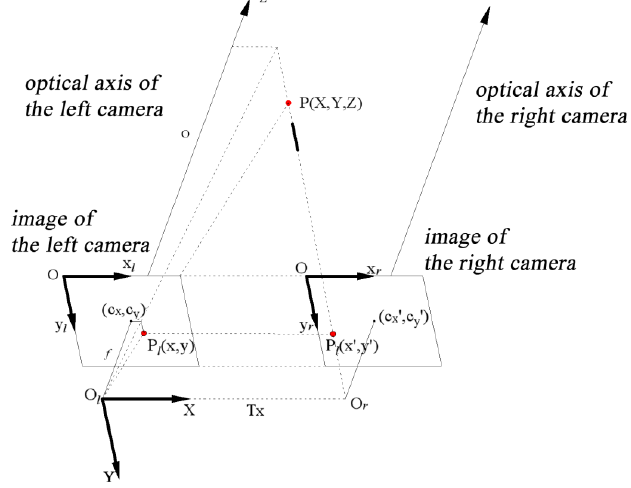
Figure 1. Binocular camera optical axis parallel model. In the optical axis parallel model, the projection point and image coordinate of the 3D spatial point P on the image plane of the left and right cameras are P l ( x , y ) and P r ( x (cid:48) , y (cid:48) ) , respectively. The image coordinates projected by the optical center of the left and right cameras are (𝑐 𝑥 , 𝑐 𝑦 ) and (𝑐 ′ 𝑥 , 𝑐 ′ 𝑦 ) , respectively. In the model, the camera coordinate system of the left camera is used as the world coordinate system. The world coordinate of P is (𝑋, 𝑌, 𝑍) . The distance between the optical centers of the left and right cameras (the